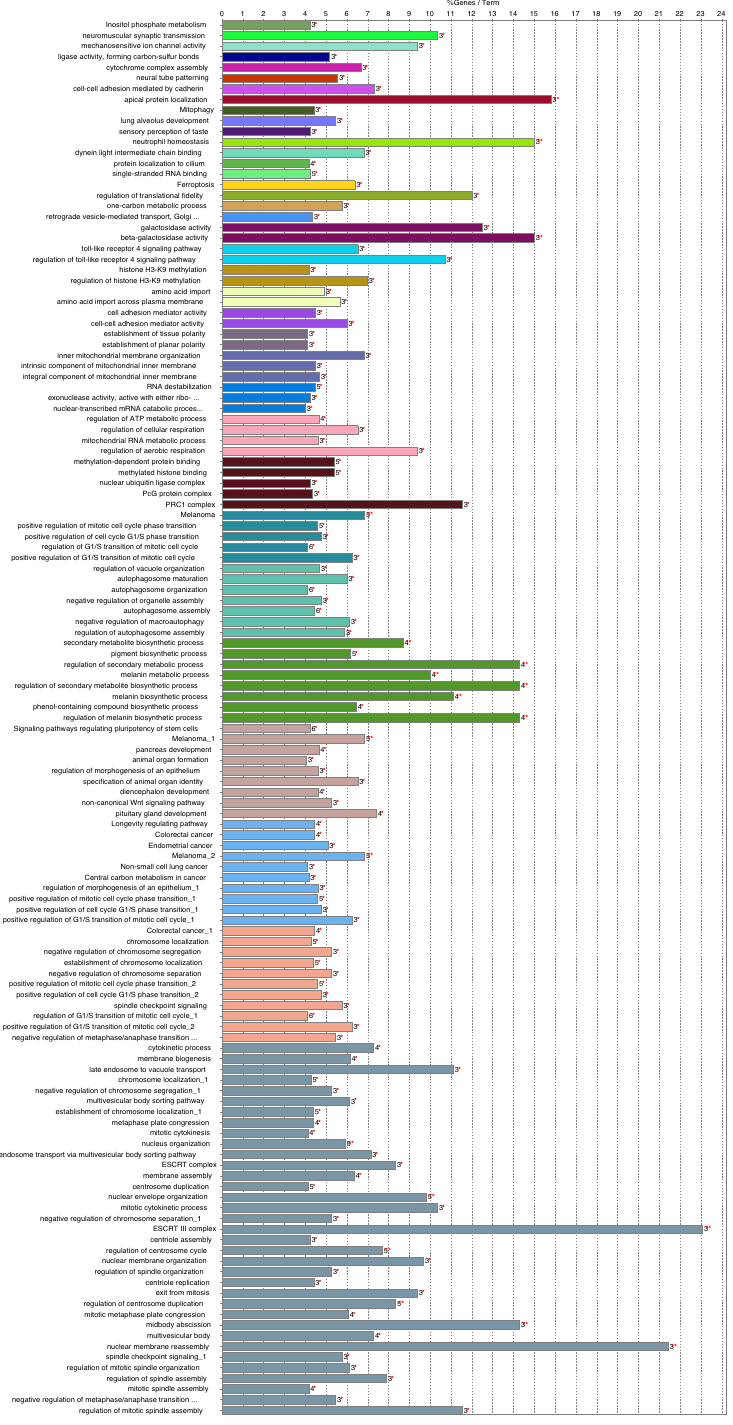
Figure 6. Functional annotation groups for genes associated with hunting ability. See Table S12 for